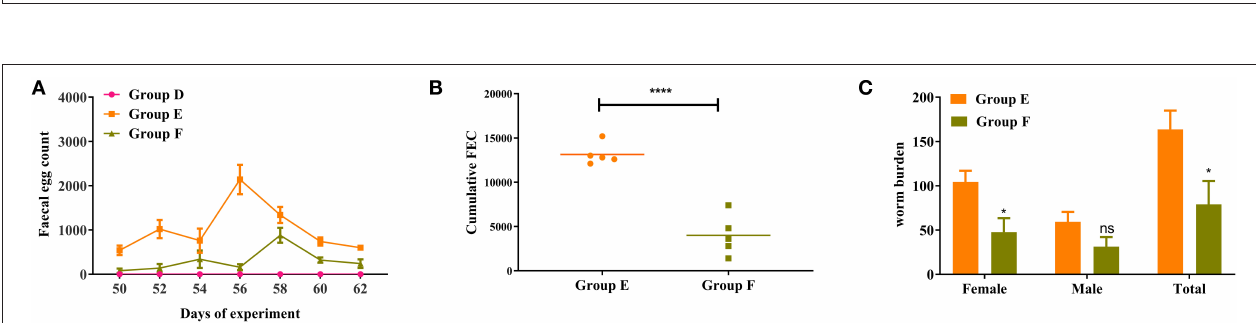
FIGURE 5 | Dynamics of egg outputs and statistics of abomasum worm burdens in trial 2. Group D, unchallenged goats; Group E, goats challenged with L3s; Group F, goats vaccinated by rHc8 antigen mixed with Freund’s adjuvants (at day 0 and 15), and challenged with L3s (at day 29). (A) FEC are presented as mean ± SEM. (B) Mean cFEC values present the data of each goat in each group. (C) Worm burdens are presented as mean ± SEM. * p < 0.05, ** p < 0.01; ns, non-significant vs. infection group, a capped line designates significance between two groups (**** p <